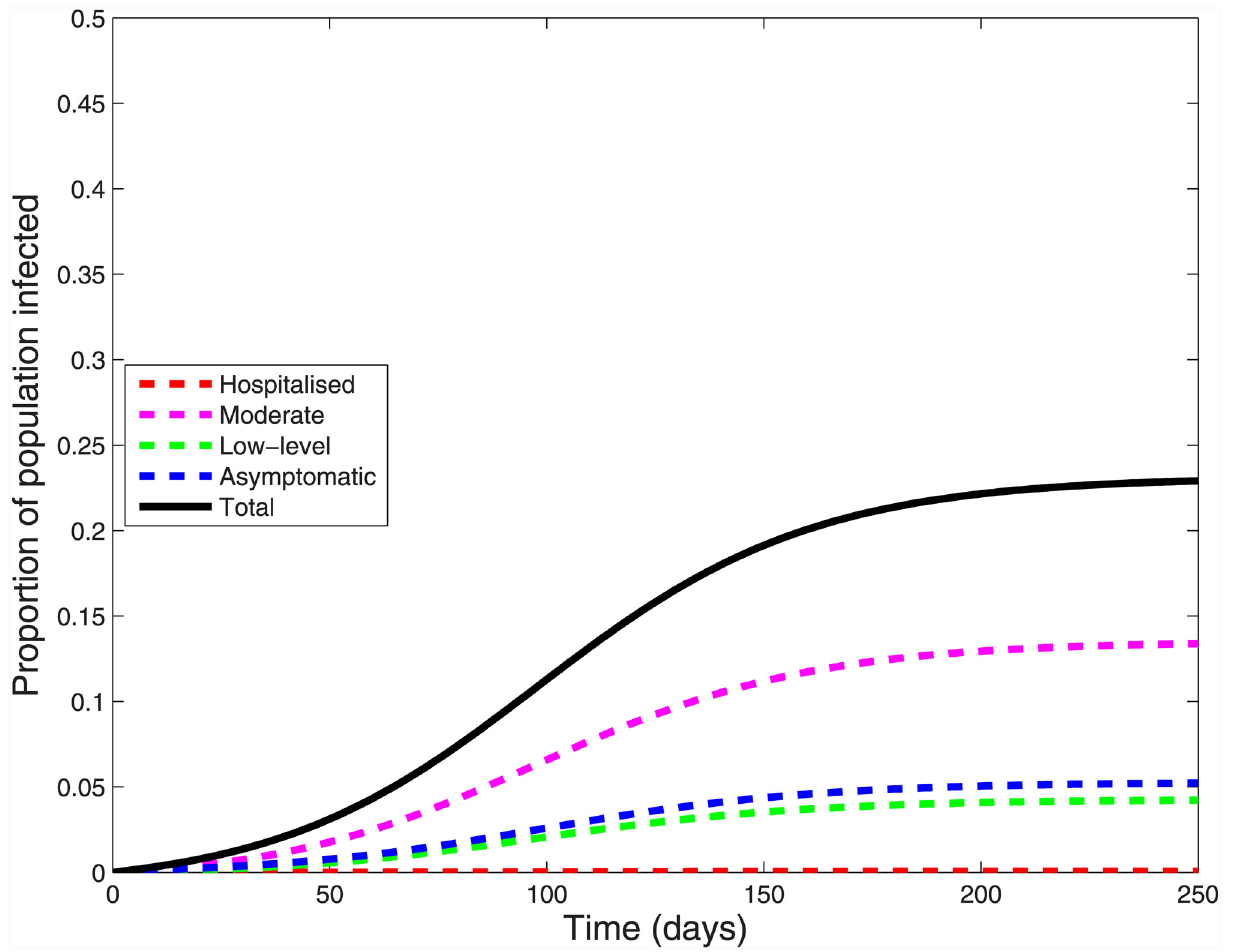
Fig 2. Cumulative incidence of influenza A(H1N1)pdm09 over time by infection severity.